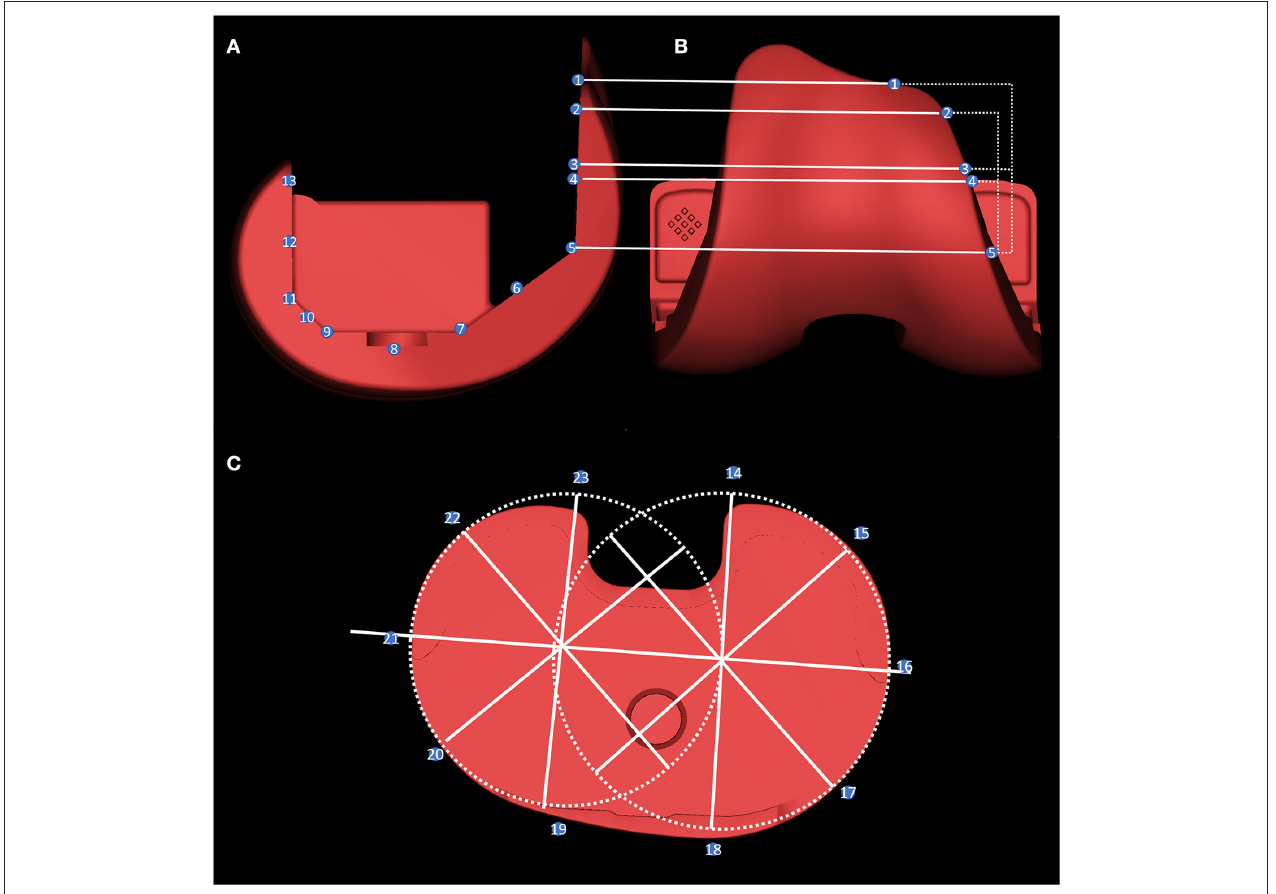
FIGURE 3 | The overhang measurement method. The femoral side was measured by taking the five planes of the prosthesis, the midpoint of each plane, and the length of the prosthesis and the bone-implant bed on the horizontal line of the inner and outer edges of points 1–13 (A,B) . For tibial overhang measurement: two external tangential circles were made at the interior and lateral edge of the prosthesis, and the difference between the length of the prosthesis and the bone-implant bed was measured every 45 ◦ on these radii at points 14–23 (C)